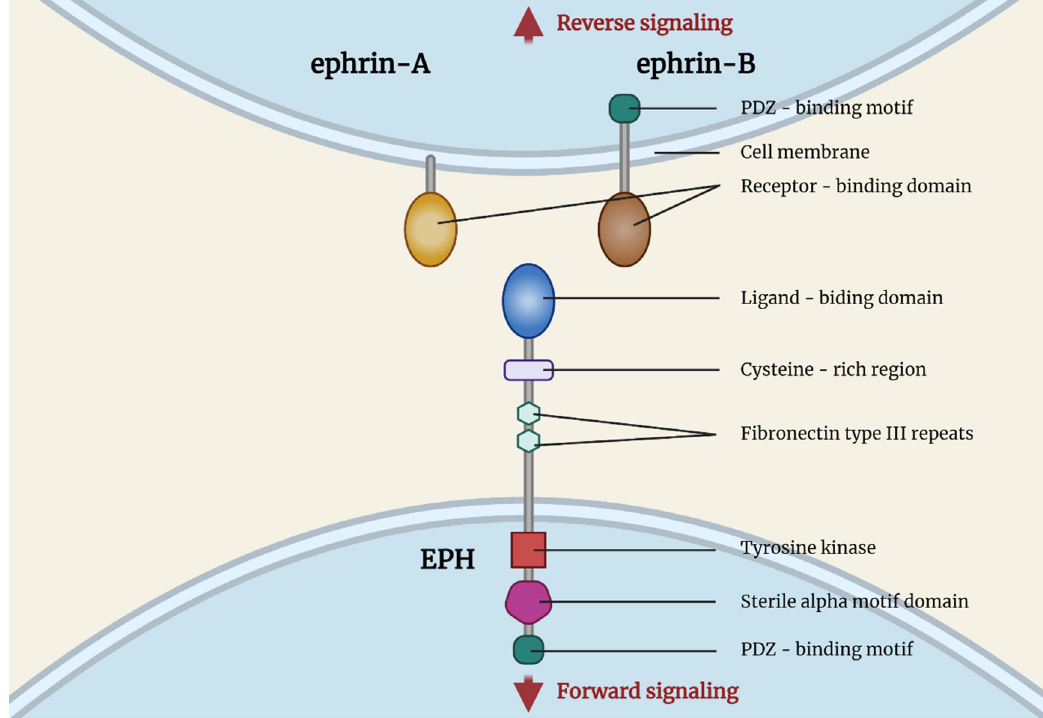
Figure 1. Structure of EPHs/ephrins. Created with